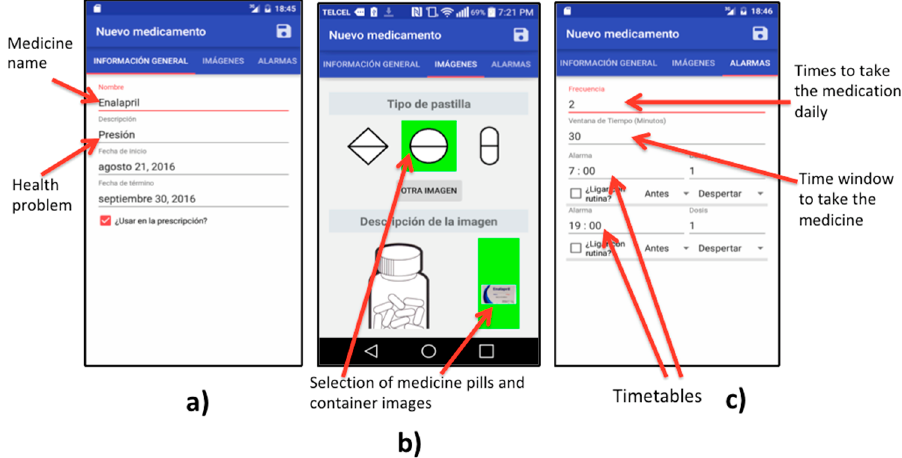
Figure 3. User interface of the administration component, which shows how it enable us to register information of each medication, such as: ( a ) pills to take; ( b ) images representing the pills and its containers; and ( c ) the timetables to take each medication and its daily